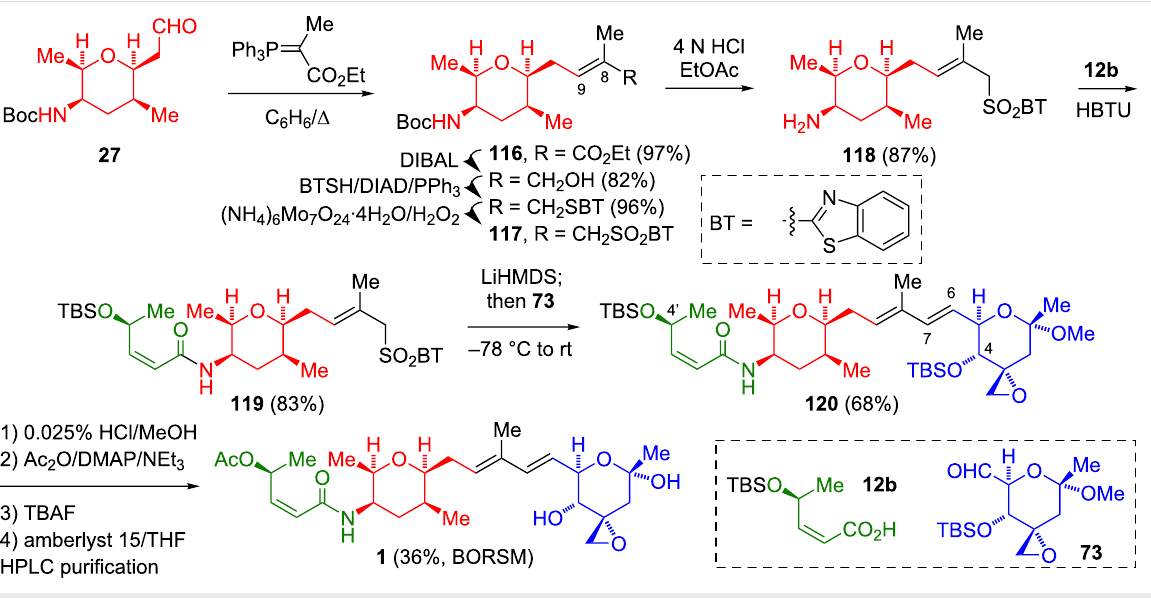
Scheme 19: Fragment coupling via Wittig and modified Julia olefinations by